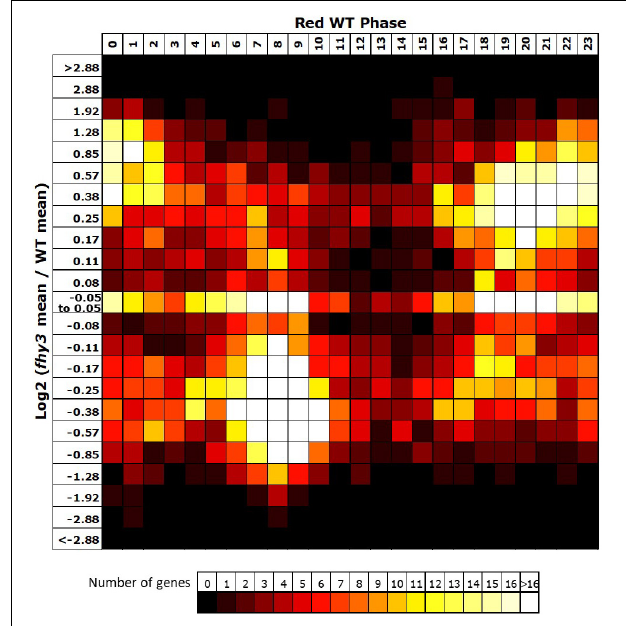
FIGURE 7 | Afternoon-phased genes in wild type show a loss of mean expression in fhy3 in red light. For all genes identified as rhythmic in wild type in red light, the change in mean expression in fhy3 was plotted against calculated phase in wild type. Bins for log2 change in mean expression also follow a log2 progression. Each expression change bin covers the range up to the value indicated, starting from the value of the preceding